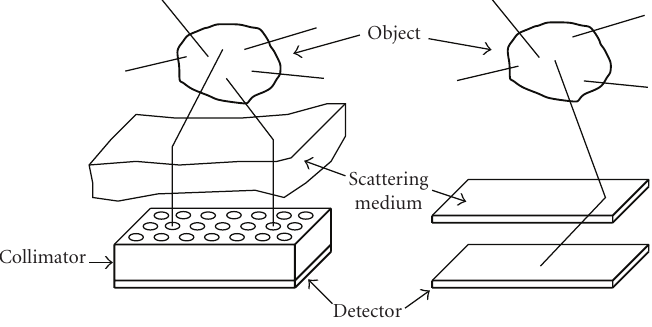
Figure 1: Two imaging modalities using scattered radiation with and without